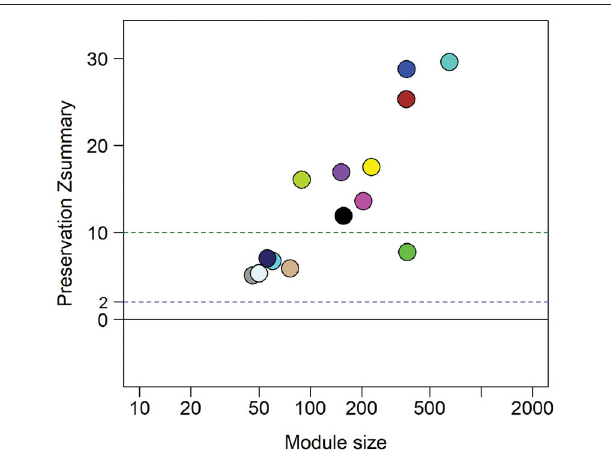
FIGURE 6 | Zsummary statistics reveal module preservation of blood profiles from women with biopsy-confirmed CT/GC-induced endometritis compared to women with biomarker-predicted STI-induced endometritis from independent TECH-N cohort. Colored circles correspond with highly correlated gene modules identified in biopsy-confirmed CT/GC-induced endometritis. The x-axis indicates the number of genes in each module; y axis is the preservation Zsummary value. The dotted lines with cutoff Zsummary of 2 and 10 indicate preservation and high level preservation